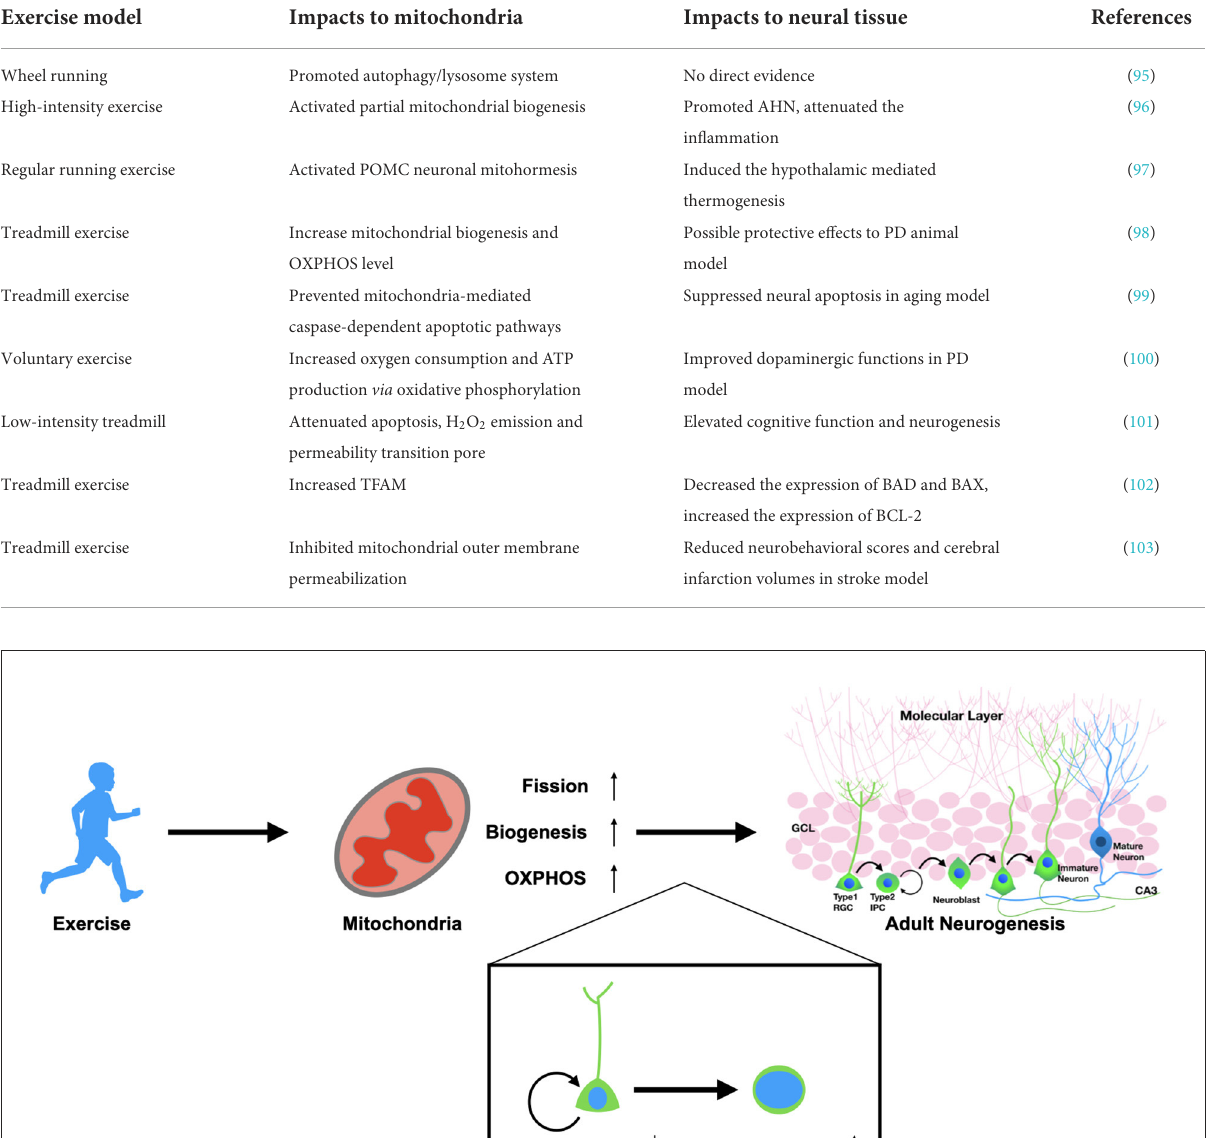
TABLE 2 Functional impacts of exercise on neuronal mitochondrial fitness/health.